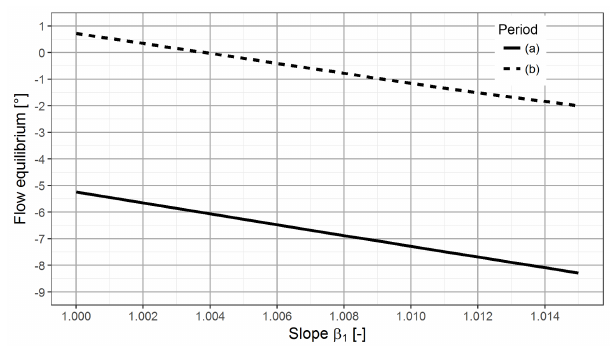
Figure 17. Sensitivity study. Anemometers are usually calibrated with a linear function including a slope and an offset. A change in the slope of the correction function results in a different flow equi- librium value. Both periods (a) and (b) from Fig. 15 are evaluated and the flow equilibrium is plotted as a function of the slope β 1